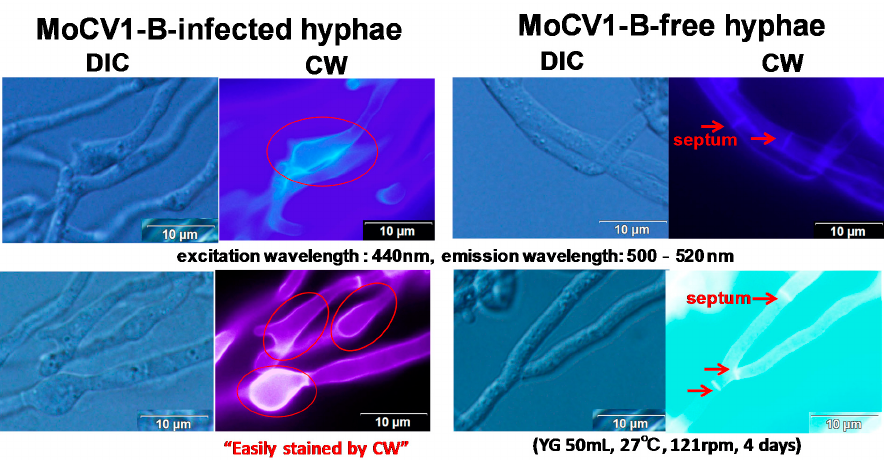
Figure 3. Influence of MoCV1-B on cell wall formation in M. oryzae hyphae. Infected and non-infected hyphae were stained with calcofluor-white (Sigma Chemical, St. Louis, MO, USA) and examined at 1000 × magnification under a light microscope (Olympus IX71, Tokyo, Japan) with differential interference contrast (DIC) optics. Calcofluor-white (CW) binds strongly to structures containing cellulose and chitin.